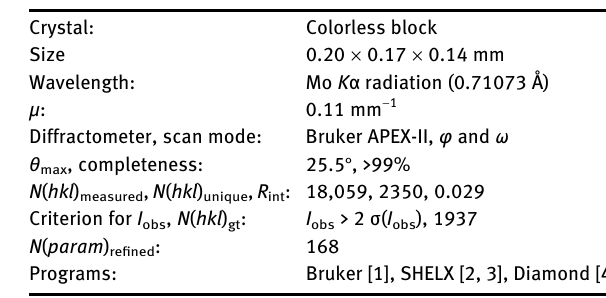
Table  : Data collection and